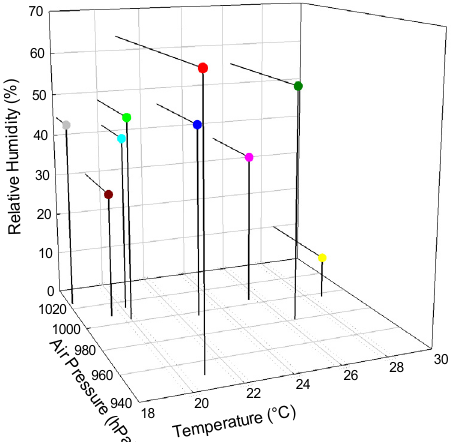
Figure 3. Values of temperature, air pressure and relative humidity during the exposures, as reported by the participants; the colors used for the participants are the same as in Figures 1 and 2. The power of the association between a specified random variable ( 𝑅 of independent random variables ( 𝑇, 𝑝, 𝑟𝐻 ) is determined using the multiple correlation method. Details of the procedure and computational results are presented elsewhere [2].